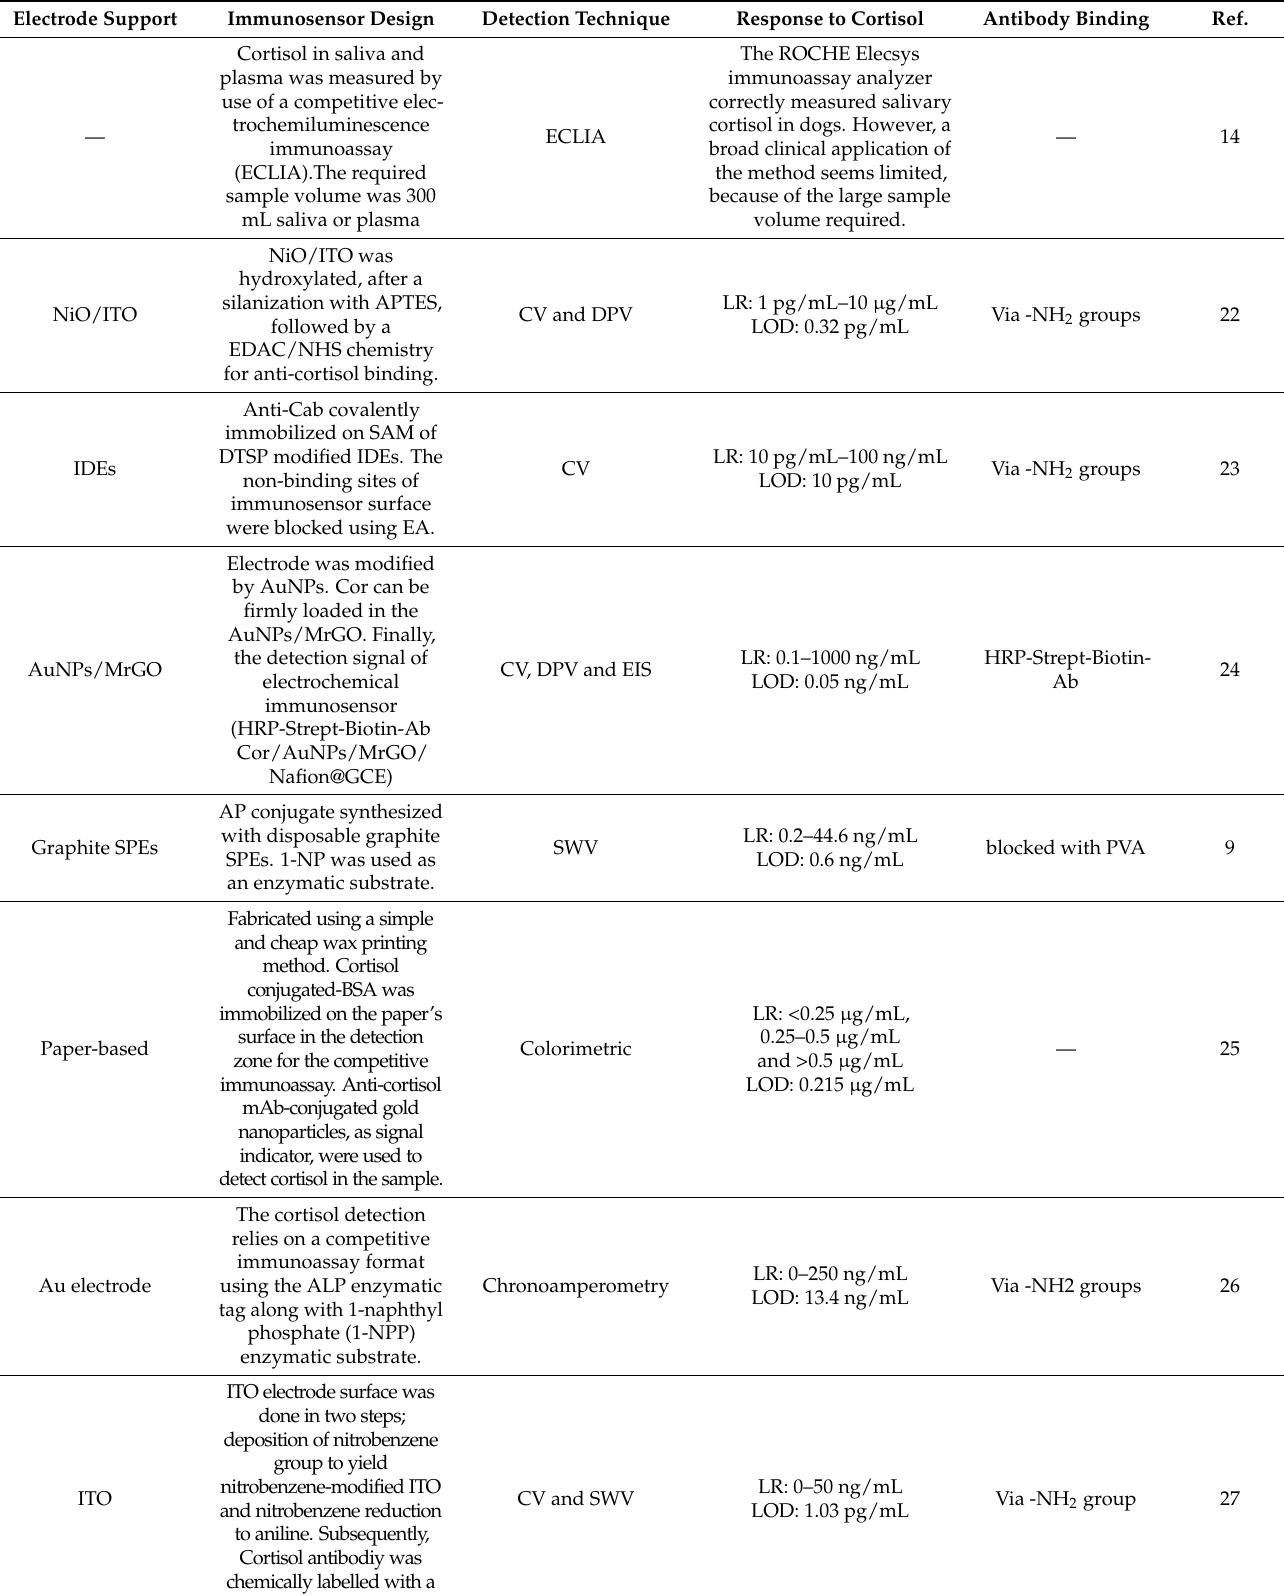
Table 1. Sensors for cortisol using different detection